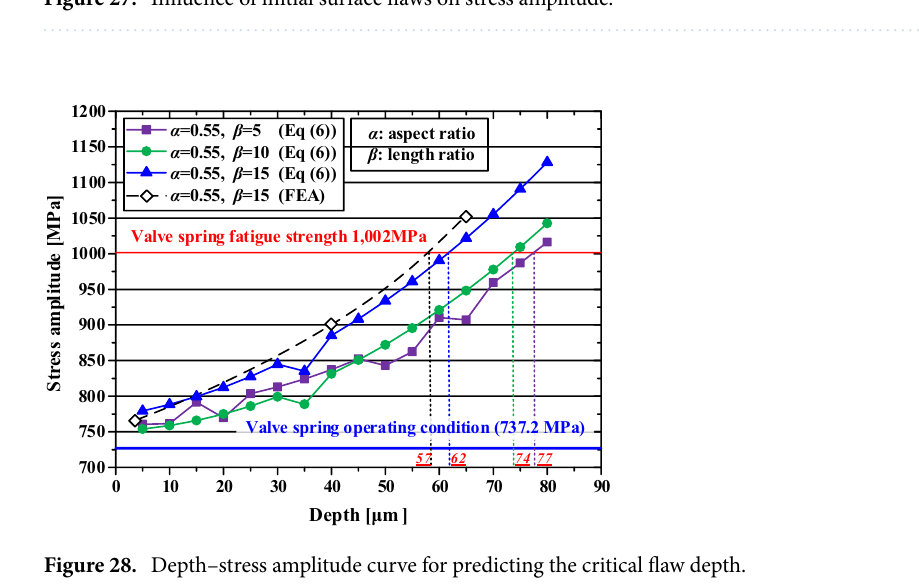
Figure 27. Influence of initial surface flaws on stress amplitude.